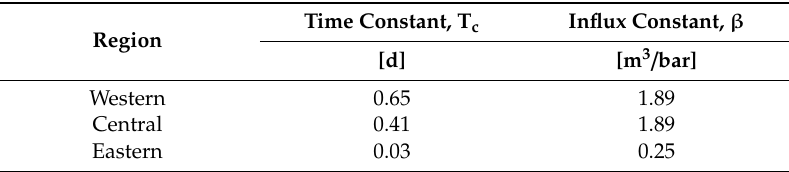
Table 2. Parameters of aquifer models.